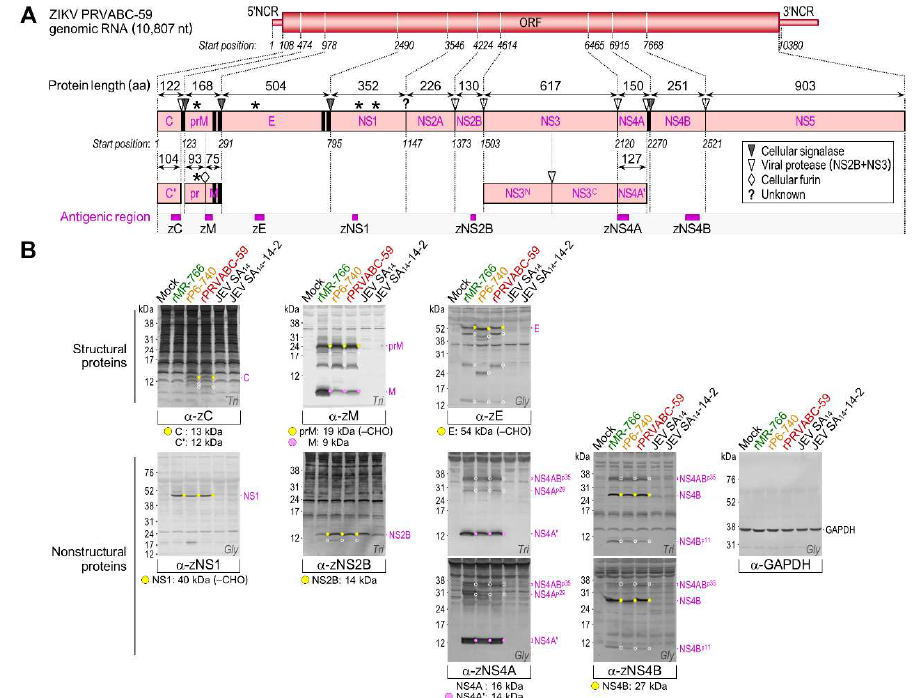
Figure 6. A panel of seven ZIKV region-specific polyclonal antibodies identifies ZIKV C, prM/M, E, NS1, NS2B, NS4A’, NS4B, and their related species in ZIKV-infected cells. ( A ) Schematic illustration showing the antigenic regions recognized by seven ZIKV region-specific rabbit antisera. The 10,807 nt genomic RNA of ZIKV PRVABC-59 consists of a 107 nt 5′NCR, a 10,272 nt ORF, and a 428 nt 3′NCR (top panel). The ORF encodes a 3423 aa polyprotein that is predicted to be cleaved by viral and cellular proteases into at least 10 mature proteins (middle panel). Marked on the polyprotein and its products are one or two transmembrane domains (vertical black bar) at the C-termini of three structural proteins (C, prM, and E) and at the junction of NS4A/NS4B, as well as four N -glycosylation sites (asterisk) in the pr portion of prM ( 70 NTT), E ( 154 NDT), and NS1 ( 130 NNS and 207 NDT). The bottom panel shows the antigenic regions (horizontal magenta bar) recognized by seven ZIKV region-specific rabbit antisera. ( B ) Identification of viral proteins in ZIKV-infected cells by immunoblotting. Vero cells were mock-infected or infected at MOI 1 with each of three ZIKVs (rMR-766, rP6-740, and rPRVABC-59) or two JEVs (SA 14 and SA 14 -14-2, for comparison). At 20 h post-infection, total cell lysates were separated by SDS-PAGE on a glycine (Gly) or tricine (Tri) gel and analyzed by immunoblotting with each of the seven ZIKV region-specific rabbit antisera or α-GAPDH rabbit antiserum as a loading and transfer control. Molecular size markers are given on the left of each blot, and major ZIKV proteins are labeled on the right. Provided below each blot are the estimated molecular sizes of predicted ZIKV proteins, and marked on the blot are the predicted proteins (yellow or pink dot) and presumed cleavage intermediates or further cleavage/degradation products (white circle). CHO, N -glycosylation.